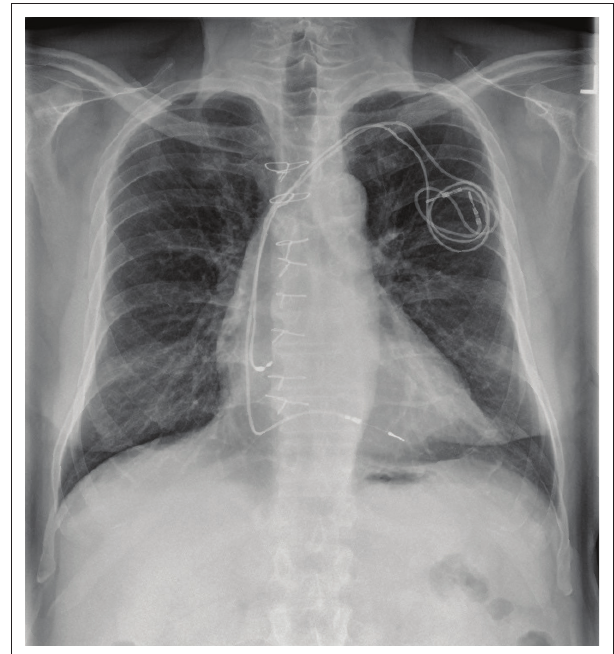
FIGURE 3: A chest radiograph (CXR) showing abandoned pacemaker leads in the right atrium and the right